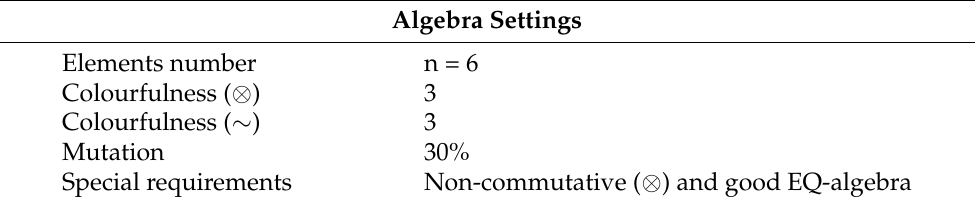
Table 7. EQCreator settings for non-commutative multiplication